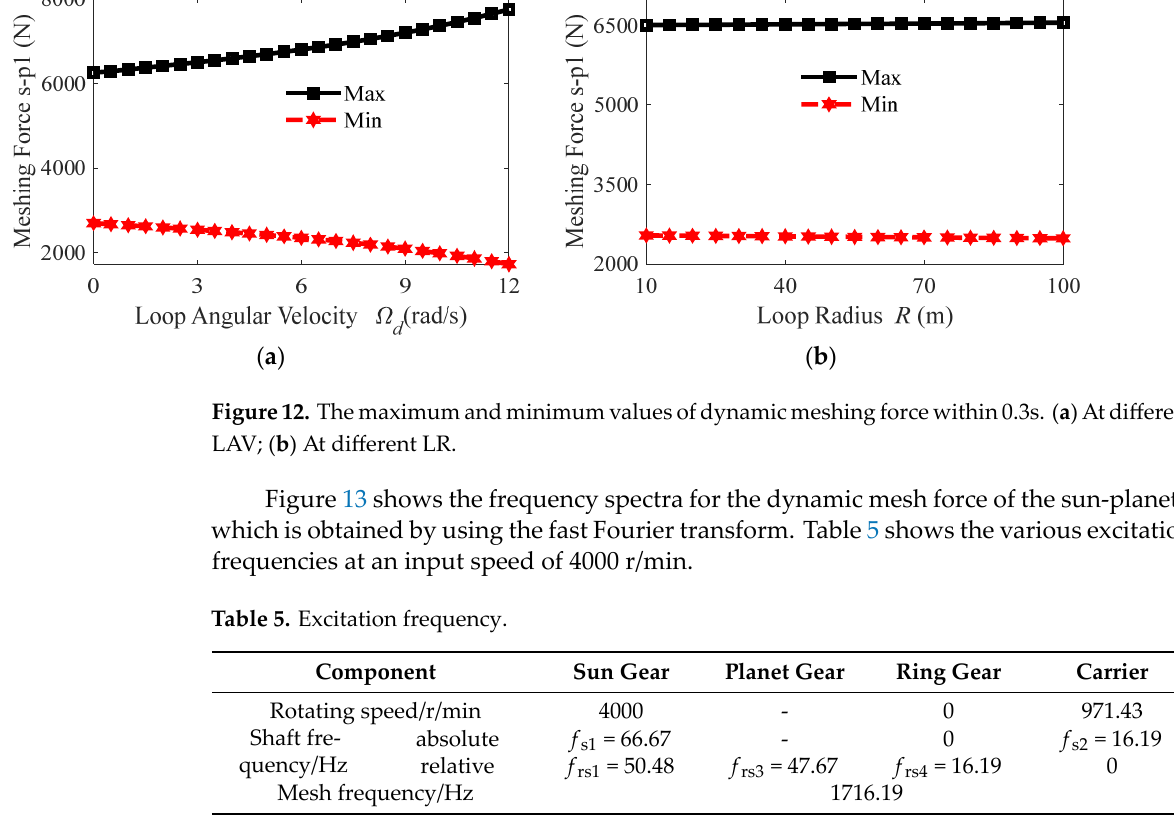
Figure 13. Frequency spectra of the dynamic meshing force of sun-planet1. ( a ) At different LAV; ( b ) At different LR;. ( c ) At different input speeds of sun gear. Table 5. Excitation frequency. Component